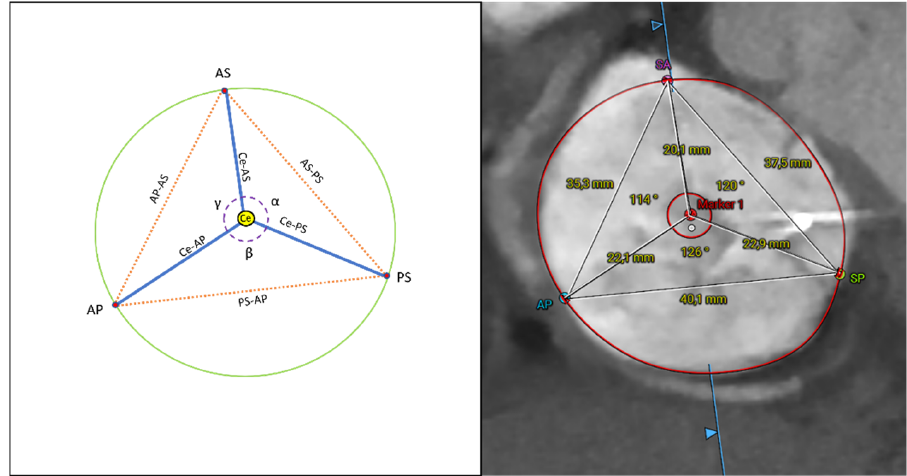
Figure 1. Analysis overview of the novel CT scan measurements. α : alpha; AP: anter-posterior commissure; AS: antero-septal commissure; β : beta; Ce: centroid; γ : gamma PS: postero-septal commissure; SA: septal-anterior commissure; SP: septal-posterior commissure. All annular measurements were taken in both end-systole and end-diastole. Using the multiplanar reconstruction, we obtained right atrium (RA) and right ventricle (RV) dimensions in two long-axis orthogonal views (four- and two-chamber views). The distance between the annulus and the atrial roof and the distance between the annulus and the ventricular apex were measured in both end-systole and end-diastole. Finally, multiplanar reconstruction at mid-systole was used to determine the degree of tethering of each leaflet, the leaflets tenting height (or coaptation depth) in four- and two-chamber views, and the anatomical regurgitant orifice area (AROA) [3,9,14,20] (Figure 2). Additional measurements of the anatomical regurgitant orifice (ARO) were obtained, named the perimeter, maximal and minimum distance, and gap between the septal and anterior leaflet (SA-gap) and between the septal and posterior leaflet